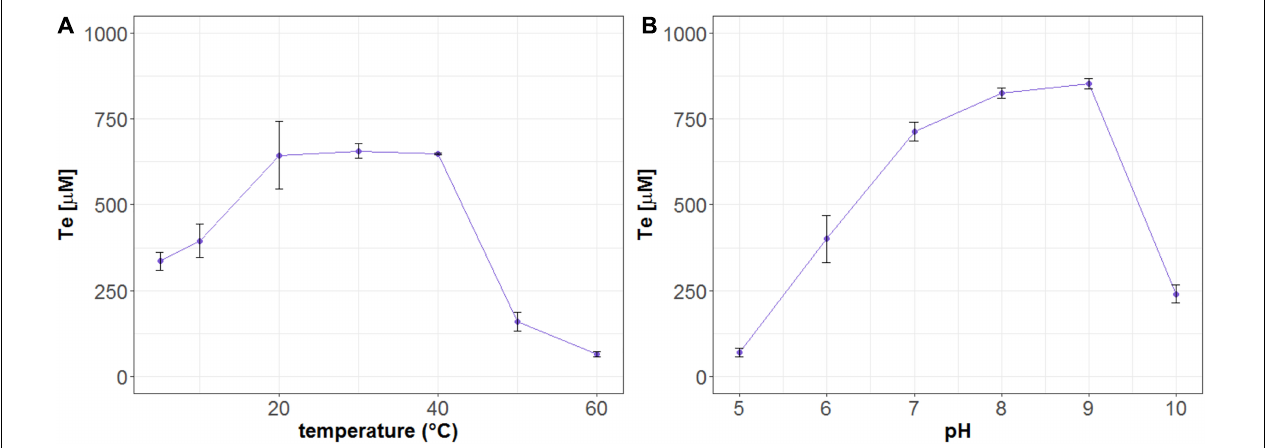
FIGURE 5 | Formation of Te ( µ M) after hydrolysis of MHET by Mle046. The release of Te by Mle046 was quantified after 20 min at (A) different temperatures and (B) different pH values. Error bars indicate standard deviation ( n = 3).